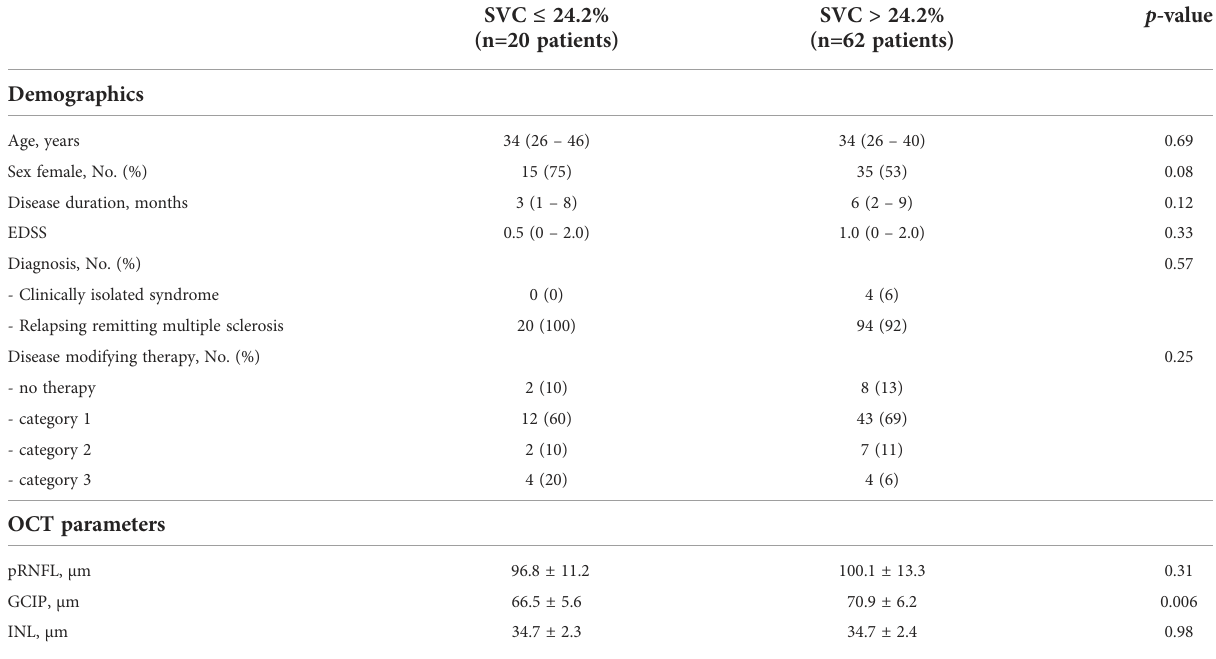
TABLE 5 Demographics and OCT parameters in patients with SVC vessel densities of ≤ 24.2% and > 24.2%.